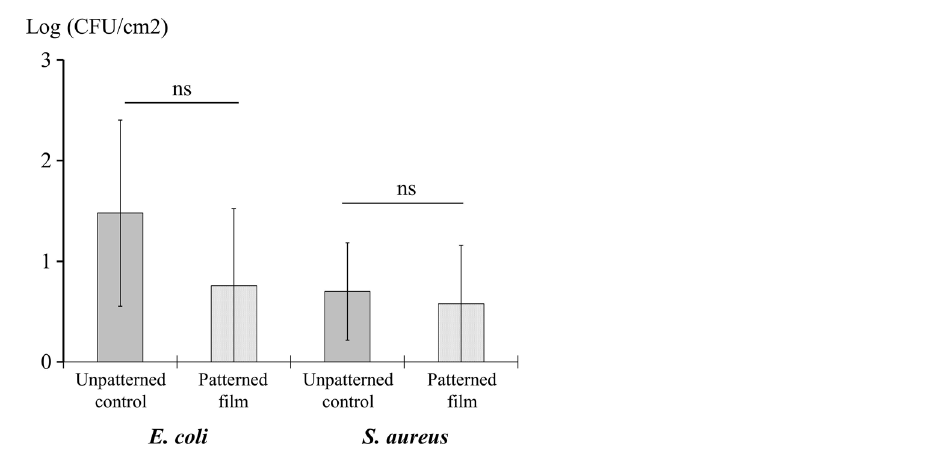
Figure 6. Immersion assay. Anti-attachment activity of a PP patterned film on E. coli and S. aureus studied by the immersion method. Bars represent average bacterial counts expressed as log (CFU/cm 2 ). ns no